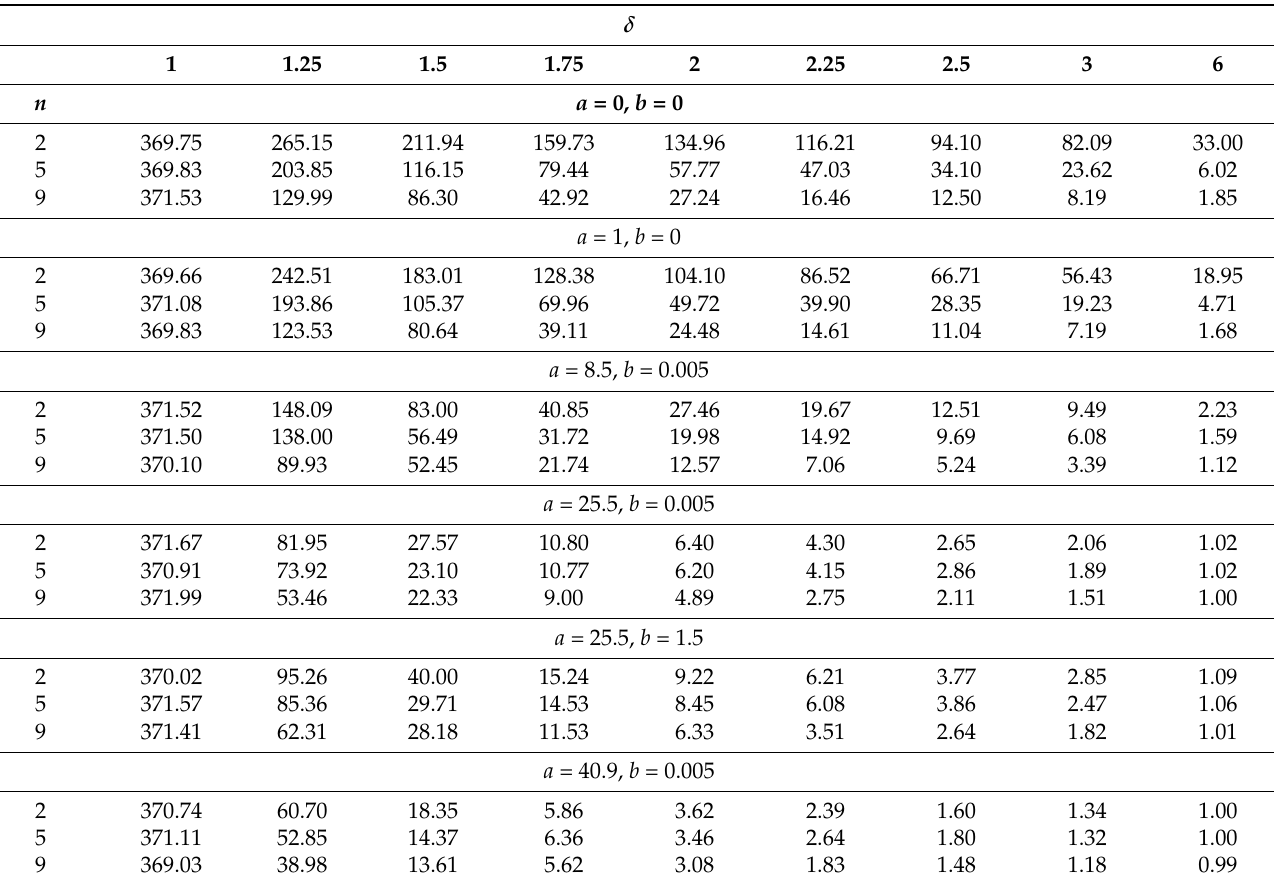
Table 3. Run length profile of the Bayesian-I Shewhart-type control chart with different sample sizes and hyperparameter values at α = 0.0027 with ARL ≈